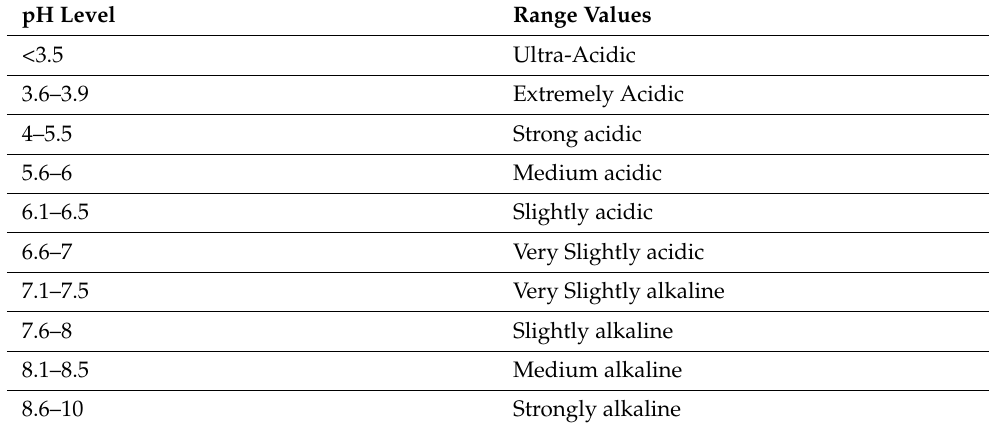
Table 1. Soil pH range